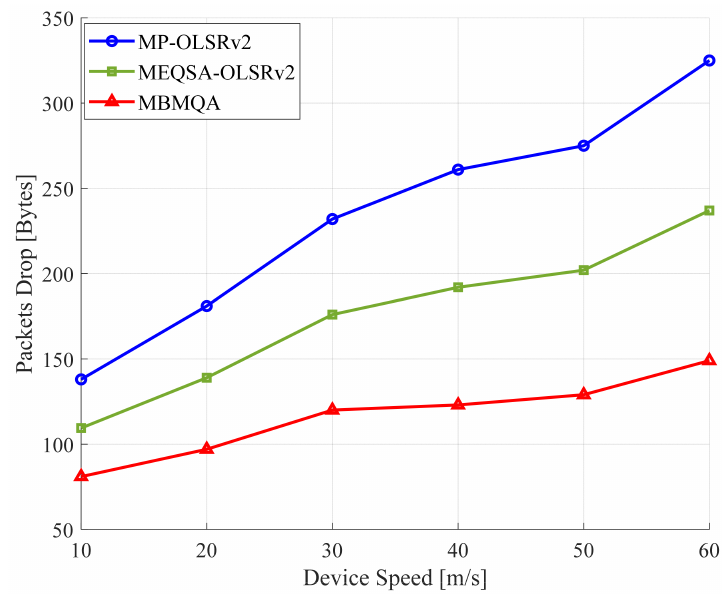
Figure 7. Packet Drop for various device